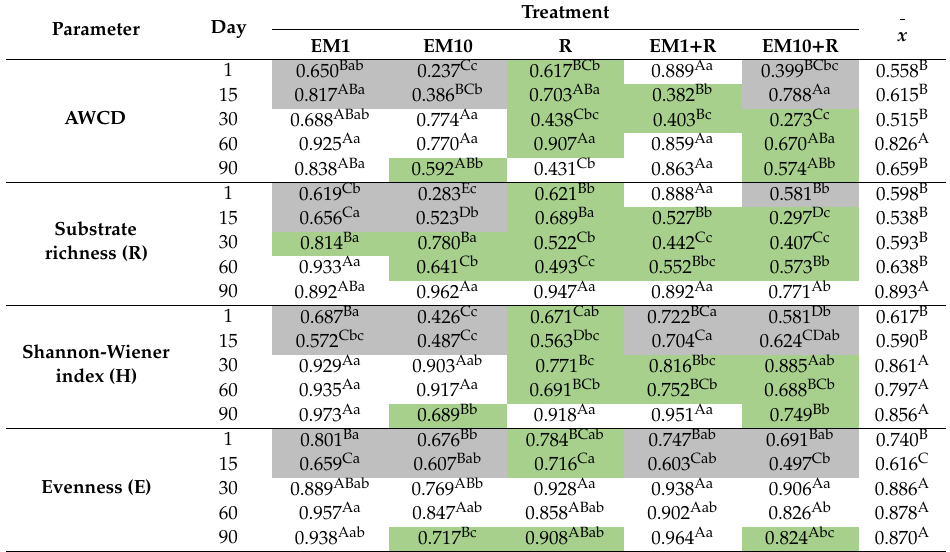
Table 5. The resistance (RS) index for the CLPP indices.